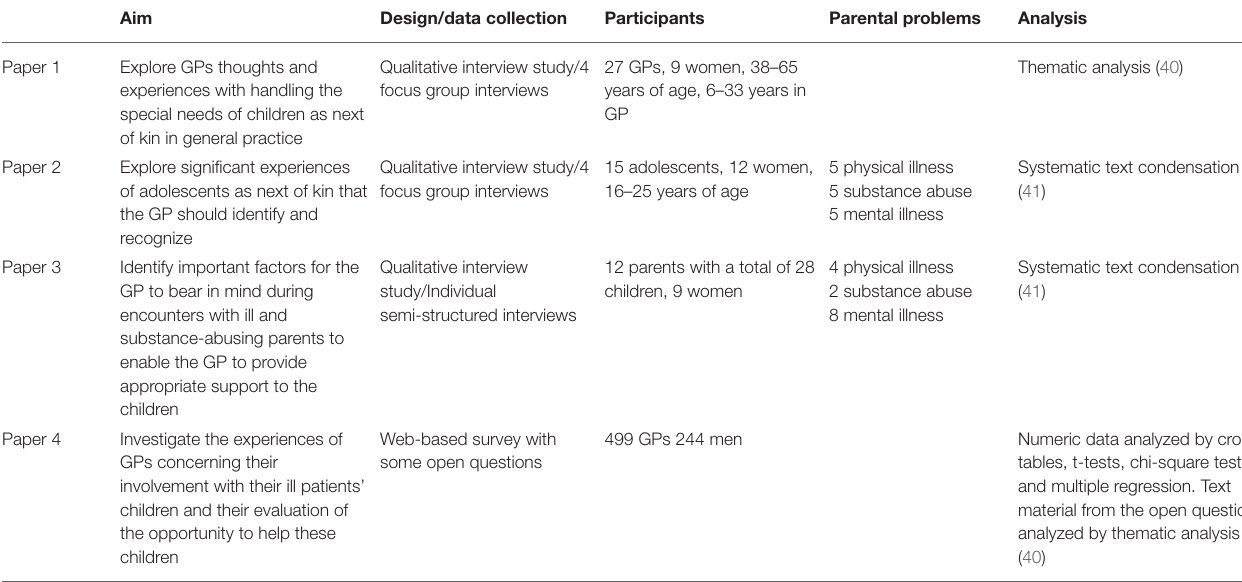
TABLE 1 | Overview of the four articles in the project Burdened Children as Next of Kin and the General Practitioner. Aim